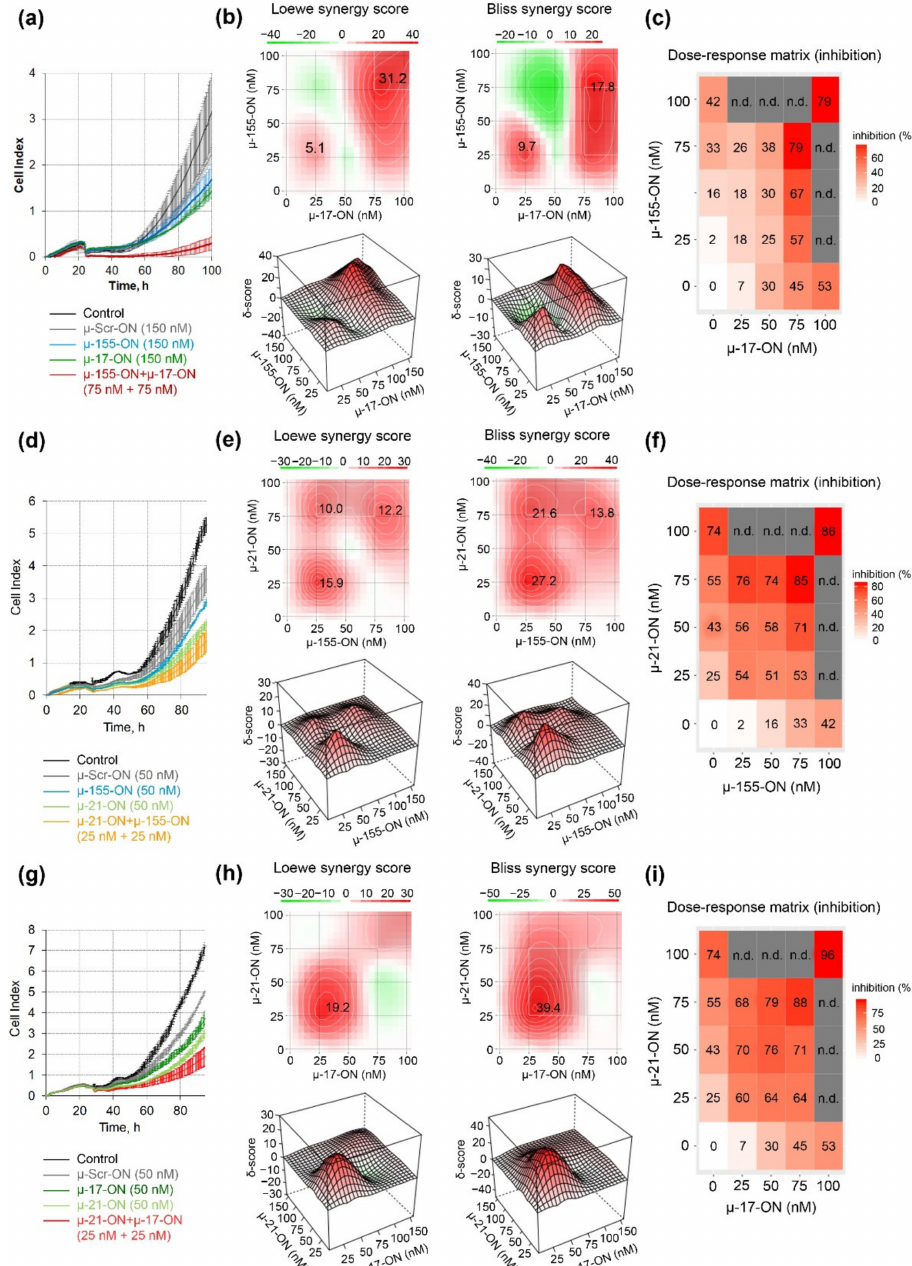
Figure 2. Antiproliferative effect of oligonucleotide cocktails µ -17-ON/ µ -155-ON ( a – c ), µ -21-ON/ µ - 155-ON ( d – f ) and µ -21-ON/ µ -17-ON ( g – i ) in B16 melanoma cells. ( a , d , g ) Representative graphs of proliferation activity of B16 cells recorded in real time using the xCELLigence cell analysis system after treatment with µ -155-ON (150 nM), µ -17-ON (150 nM) and µ -17-ON/ µ -155-ON (75 + 75 nM) ( a ); with µ -21-ON (50 nM), µ 155-ON (50 nM) and µ -21-ON/ µ -155-ON (25 + 25 nM) ( d ); and with µ -21-ON (50 nM), µ -17-ON (50 nM) and µ -21-ON/ µ -17-ON (25 + 25 nM) ( g ). As a control, µ -Scr-ON was used. Control—B16 cells without treatment. Data represent mean ± s.d. ( b , e , h ) Loewe and Bliss score showing synergistic effect of oligonucleotide combinations µ -17-ON/ µ -155- ON, µ -21-ON/ µ -155-ON and µ -21-ON/ µ -17-ON on cell growth. The heatmap shows the score values for the areas with the highest synergy. The data were analyzed with the SynergyFinder software (https://synergyfinder.fimm.fi/, accessed on 14 February 2022). The synergy score < − 10— antagonism; − 10–10—additive effect; >10—synergy; ( c , f , i ) Matrices demonstrating inhibition of cell growth by different concentrations of oligonucleotides in combinations. n.d.—not